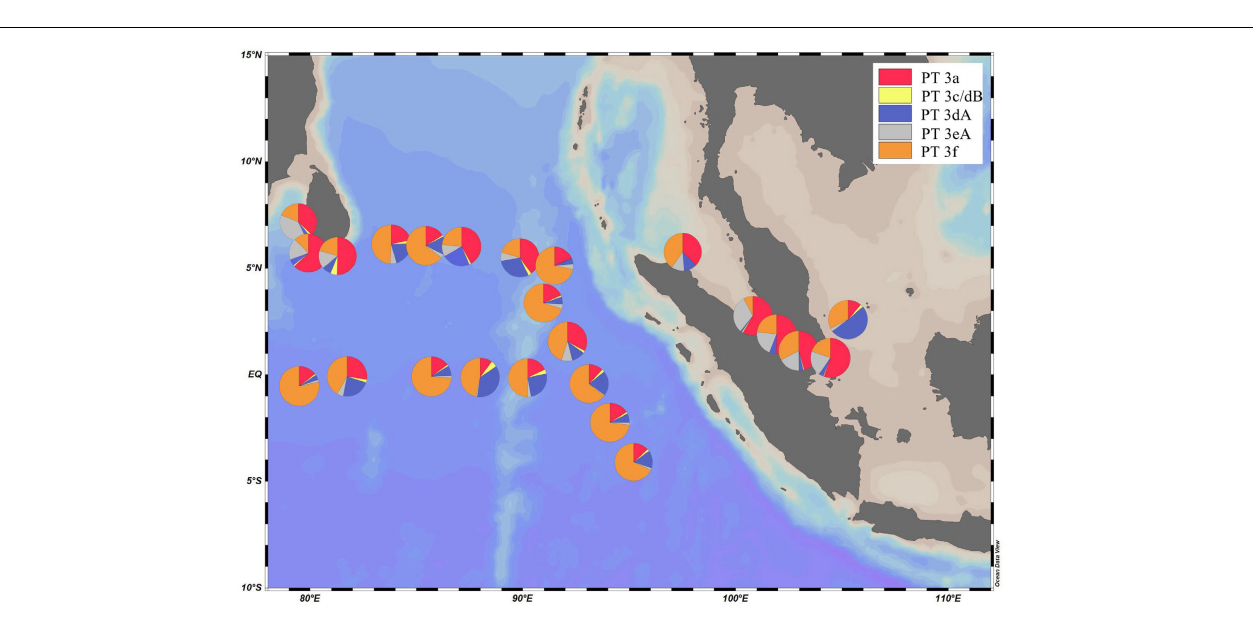
euphotic zone were mainly occupied by ESTU 3dA-C. In SSL and SSM, ESTU 3dA-F and 3dA-I were the main groups ( Figure 7 ). The divergence of different ESTUs suggested the niche partition within PT 3dA. Similarly, pronounced divergence of ESTUs within other PTs at different locations was also observed ( Figure 7 ), indicating the ecological divergence